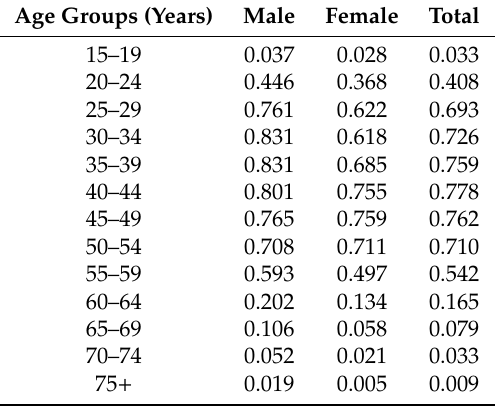
Table A2. Ratio of employed persons by demographic strata in Hungary according to the Census 2011.